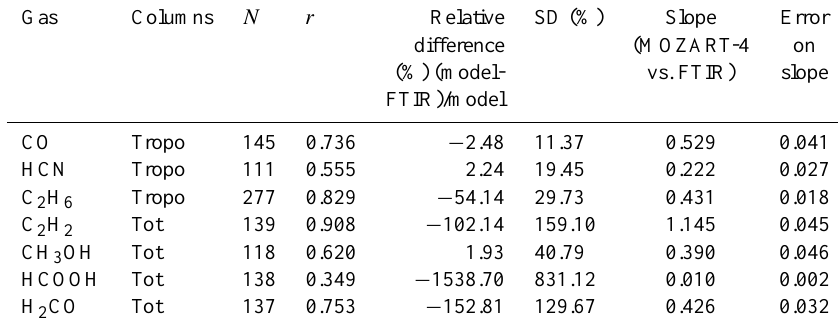
Table 4. Same as Table 3 but for